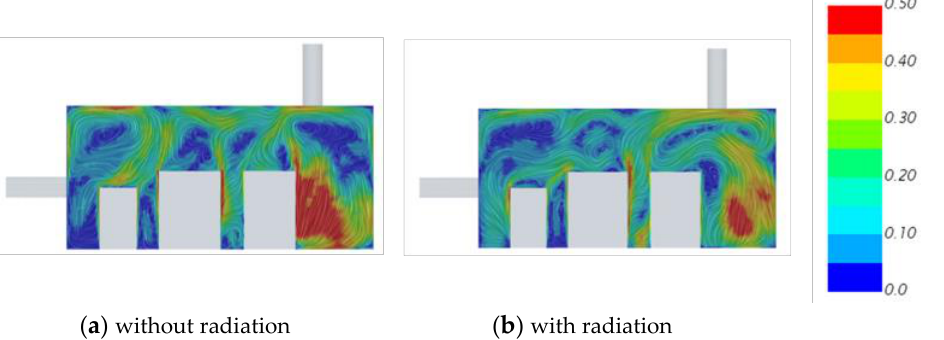
Figure 10. Cross-sectional view (Centered on Outlet 1) of the velocity magnitude contour for the cockpit underfloor equipment bay (Configuration 1).